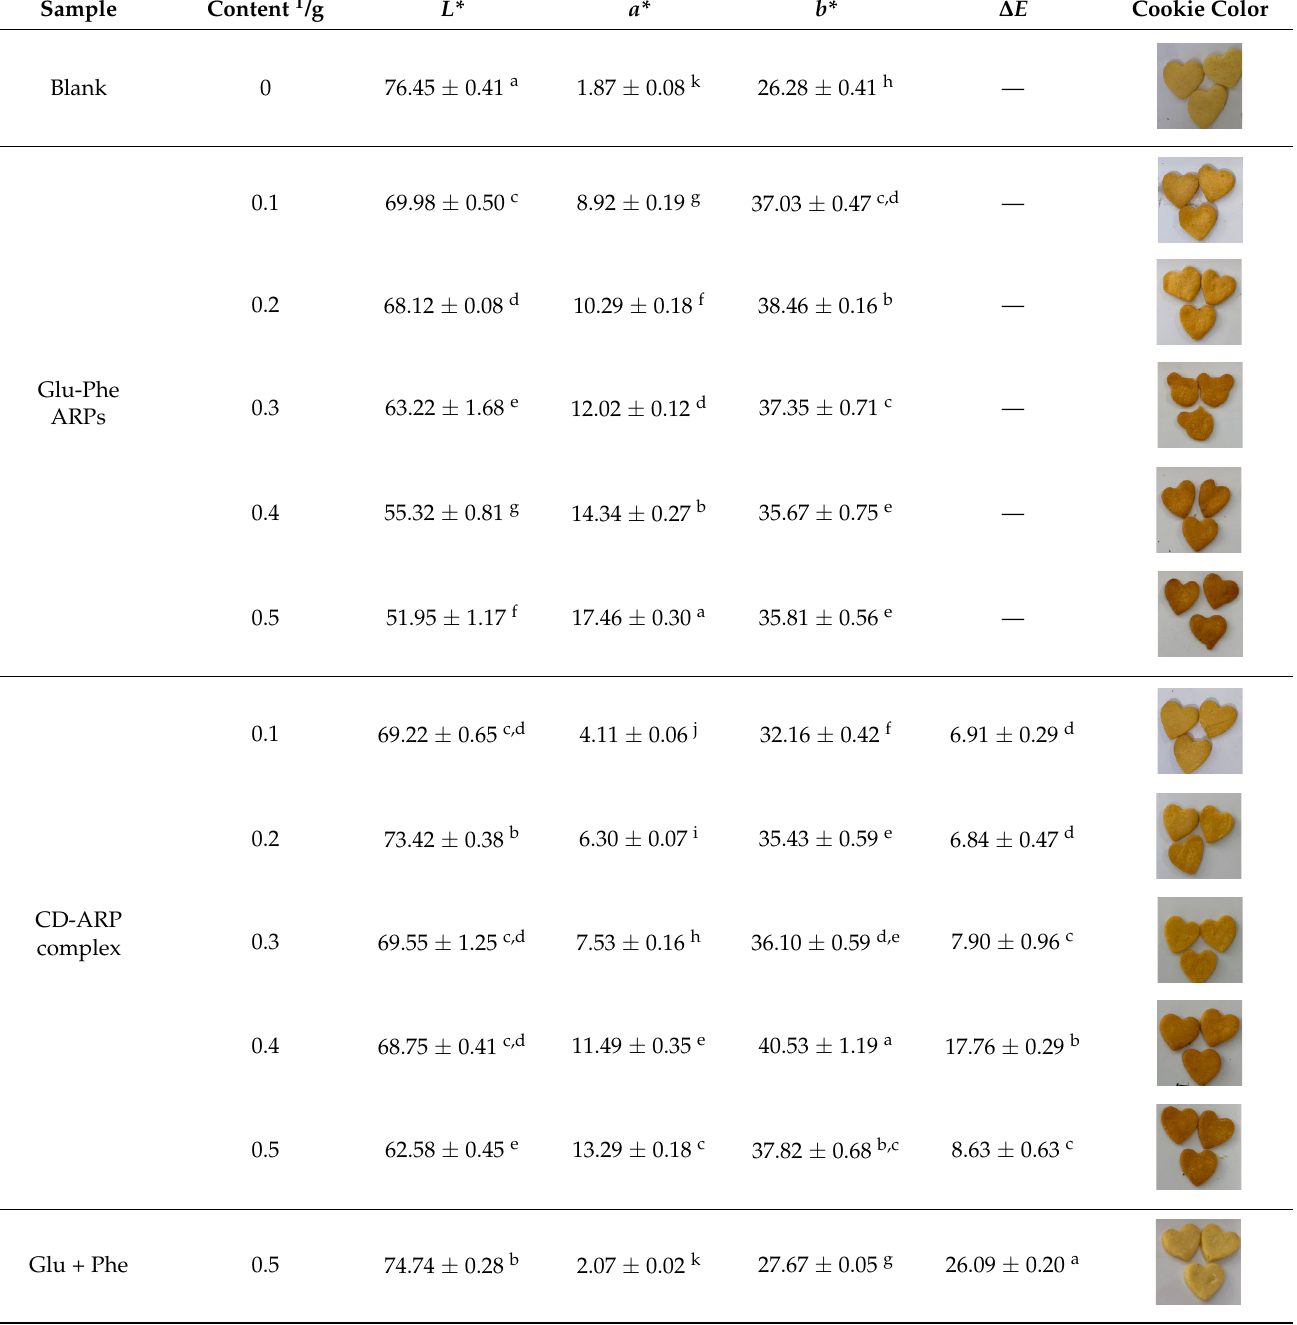
Table 2. Effect of Glu-Phe ARPs and CD-ARP complex addition on the color properties of cookies.